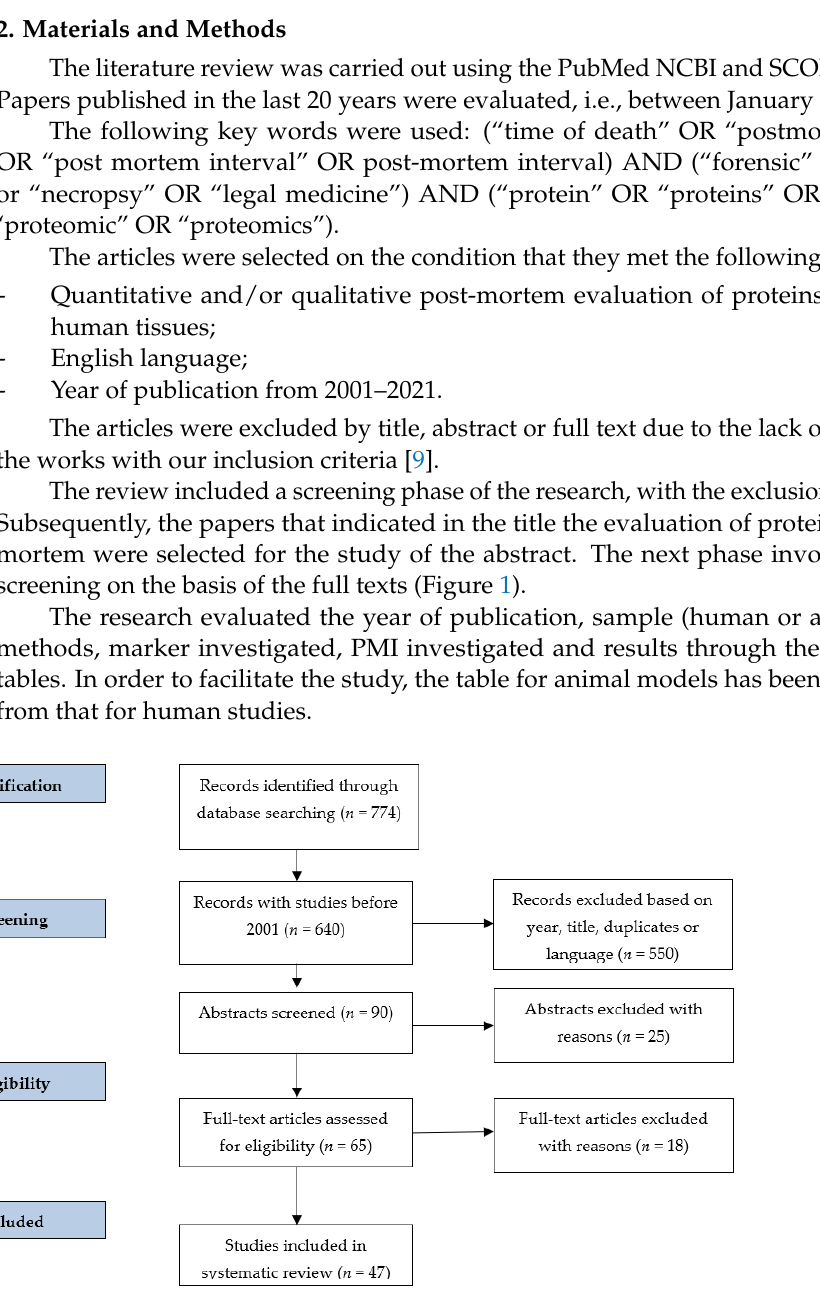
Figure 1. Algorithm followed for the selection of papers on PubMed and SCOPUS databases.